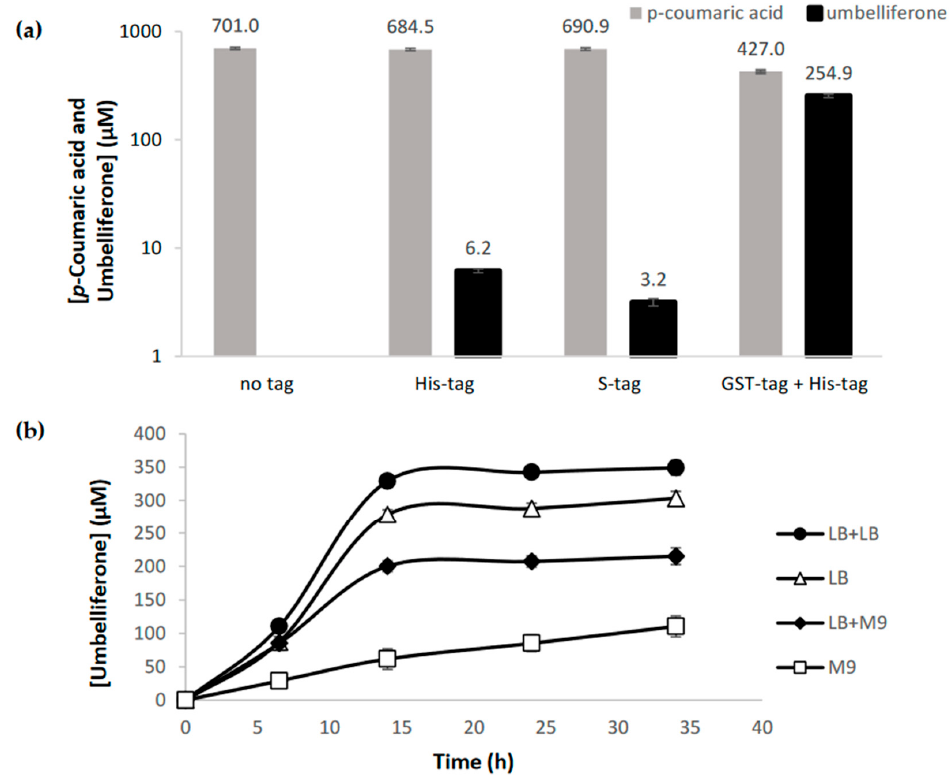
Figure 2. Umbelliferone production from p -coumaric acid using p -coumaroyl-CoA 2 ′